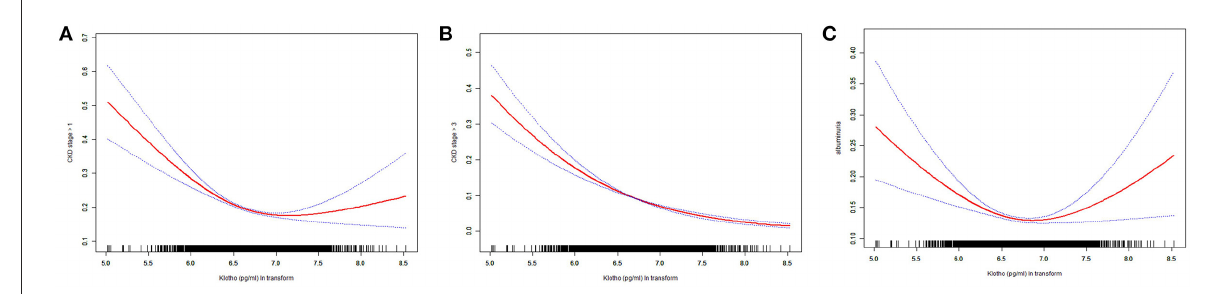
FIGURE3 Smooth curve fitting. (A) association between Klotho ln transform and whether CKD stage > 1; (B) association between Klotho ln transform and whether CKD stage > 3; (C) association between Klotho ln transform and albuminuria.